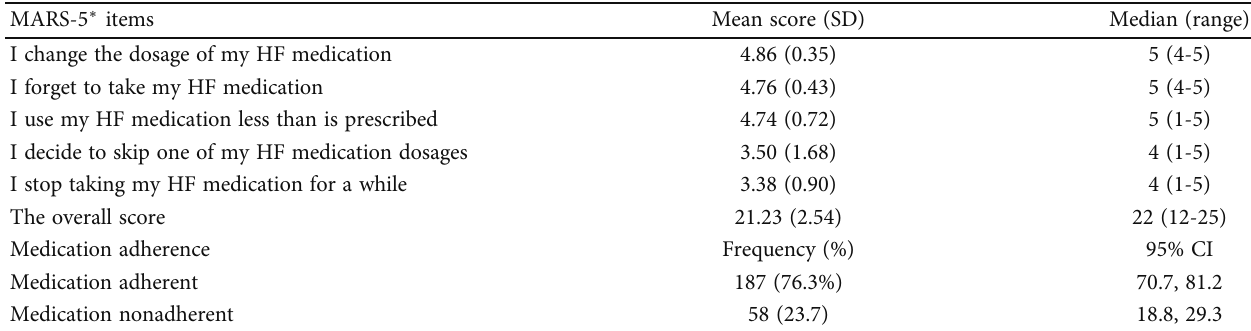
Table 2: HF patients ’ level of adherence to their medication at the University of Gondar Comprehensive Specialized Hospital, northwest Ethiopia.